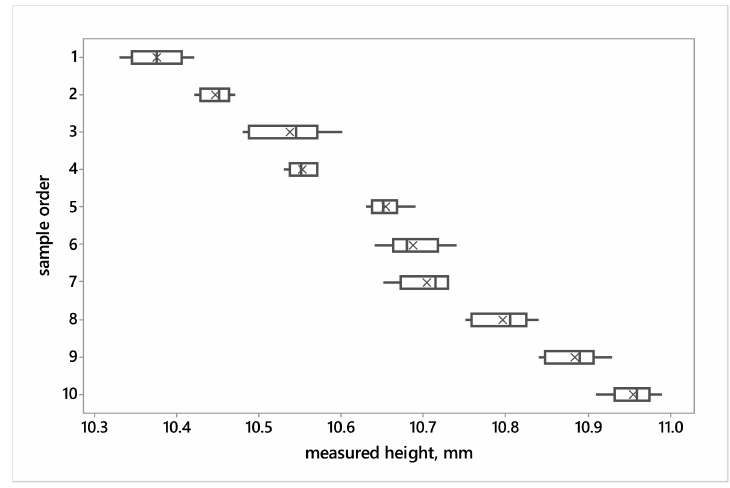
Figure 2. Box and whisker plots for arranged product samples.